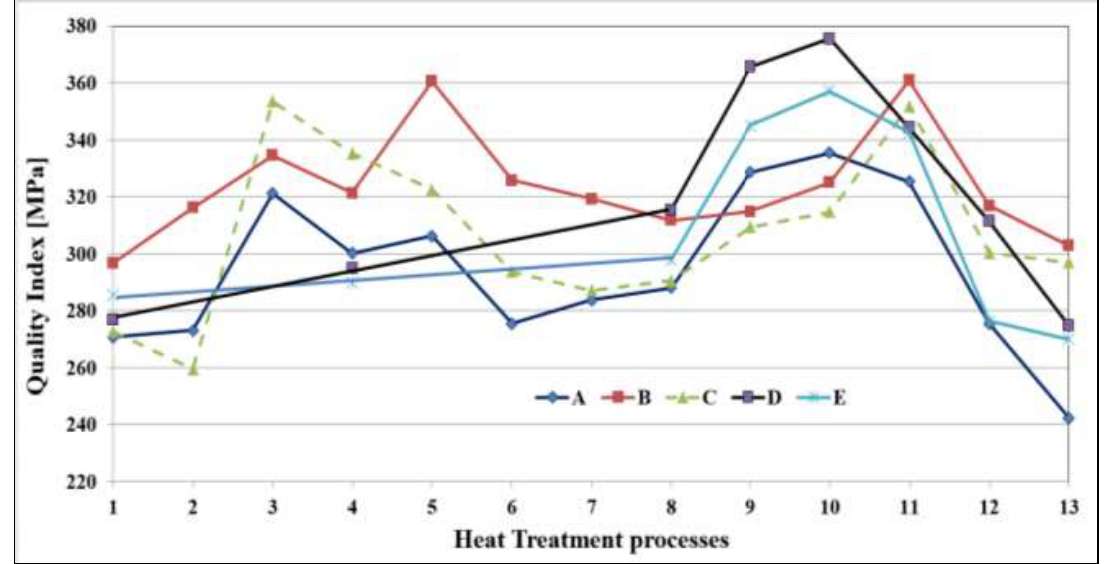
Figure 15. Quality Index-Heat Treatment relationships for the alloys tested at 250 °C.